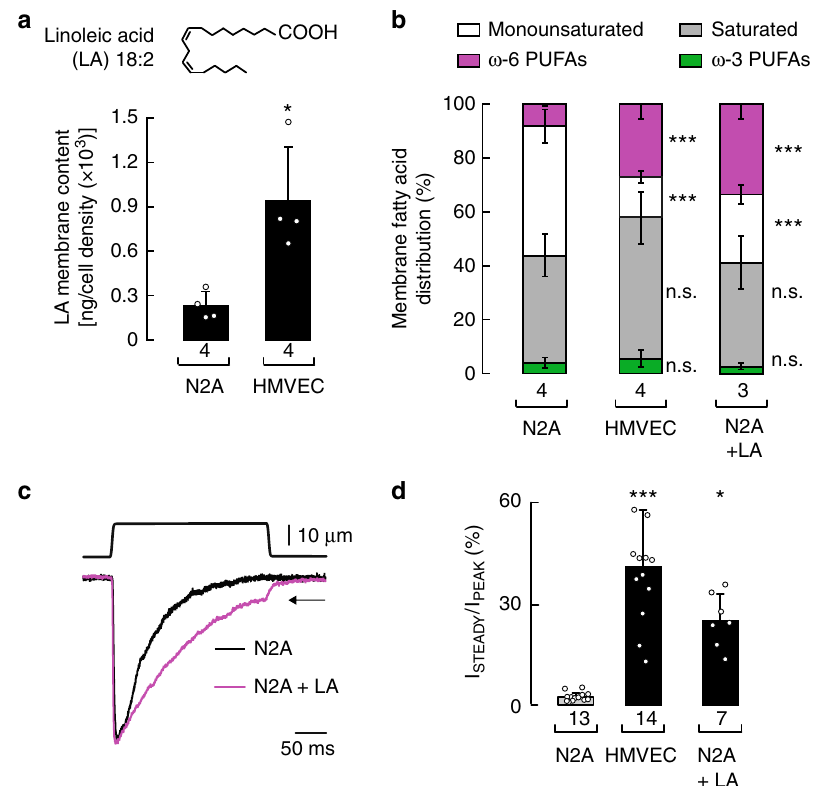
Fig. 6 Changing the cellular fatty acid distribution pro fi le modi fi es Piezo1 inactivation. a Linoleic acid (LA) membrane content in N2A cells and HMVEC, as determined by LC-MS. Bars are mean ± SD. Mann – Whitney test. b Stacked bar chart illustrating the membrane fatty acid distribution in N2A cells, HMVEC, and LA (100 µ M)-treated N2A cells, as determined by LC-MS. Bars are mean ± SD. One-way ANOVA and Bonferroni test. c Representative whole-cell patch-clamp recordings (at − 60 mV) of N2A cells and linoleic acid (LA, 100 µ M)-treated N2A cells elicited by mechanical stimulation. Traces were normalized for comparison. d Ratio of the currents at the end of the displacement pulse to the peak current ( I STEADY / I PEAK ) from macroscopic traces of N2A cells, LA (100 µ M)-treated cells, and HMVEC. Bars are mean ± SD. Kruskal – Wallis and Dunn ’ s multiple comparisons test. Asterisks indicate values signi fi cantly different from control ( ∗∗∗ p < 0.001 and ∗ p < 0.05) and n.s. indicates not signi fi cantly different from the control. n is denoted above the x